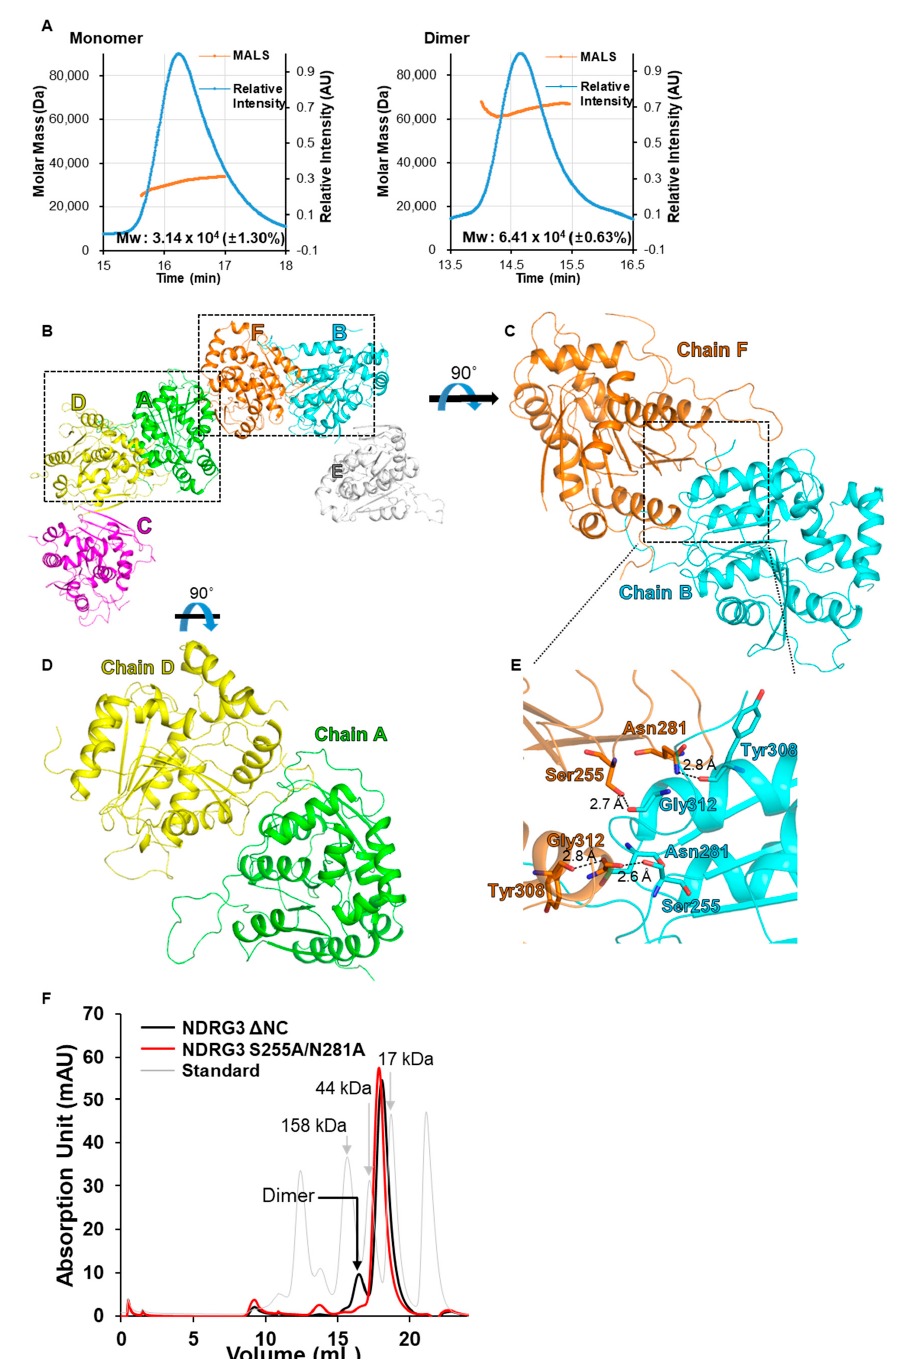
Figure 2. Dimeric interactions of NDRG3 Δ NC. ( A ) SEC-MALS analyses of the NDRG3 Δ NC monomer and dimer. The blue line indicates the relative absorbance of protein during size-exclusion chromatography, and the orange line represents the mass of the molecules analyzed by MALS. ( B ) A hexamer structure of NDRG3 Δ NC in an asymmetric unit (ASU). Each NDRG3 Δ NC structure is represented as a cartoon model in different colors and chain numbers are denoted as letters with the same color. ( C ) Dimeric interactions of chain B and chain F in an ASU. ( D ) Dimeric interactions of chain A and chain D in an ASU. ( E ) A close-up view of hydrogen bonds between chain B and chain F. Residues involved in hydrogen bonding were shown in stick models with labels. ( F ) Chromatograms of NDRG3 ∆ NC and S255A / N281A from analytical size exclusion chromatography. The grey chromatogram indicates a gel filtration standard profile (Bio-Rad #1511901, Hercules, CA,